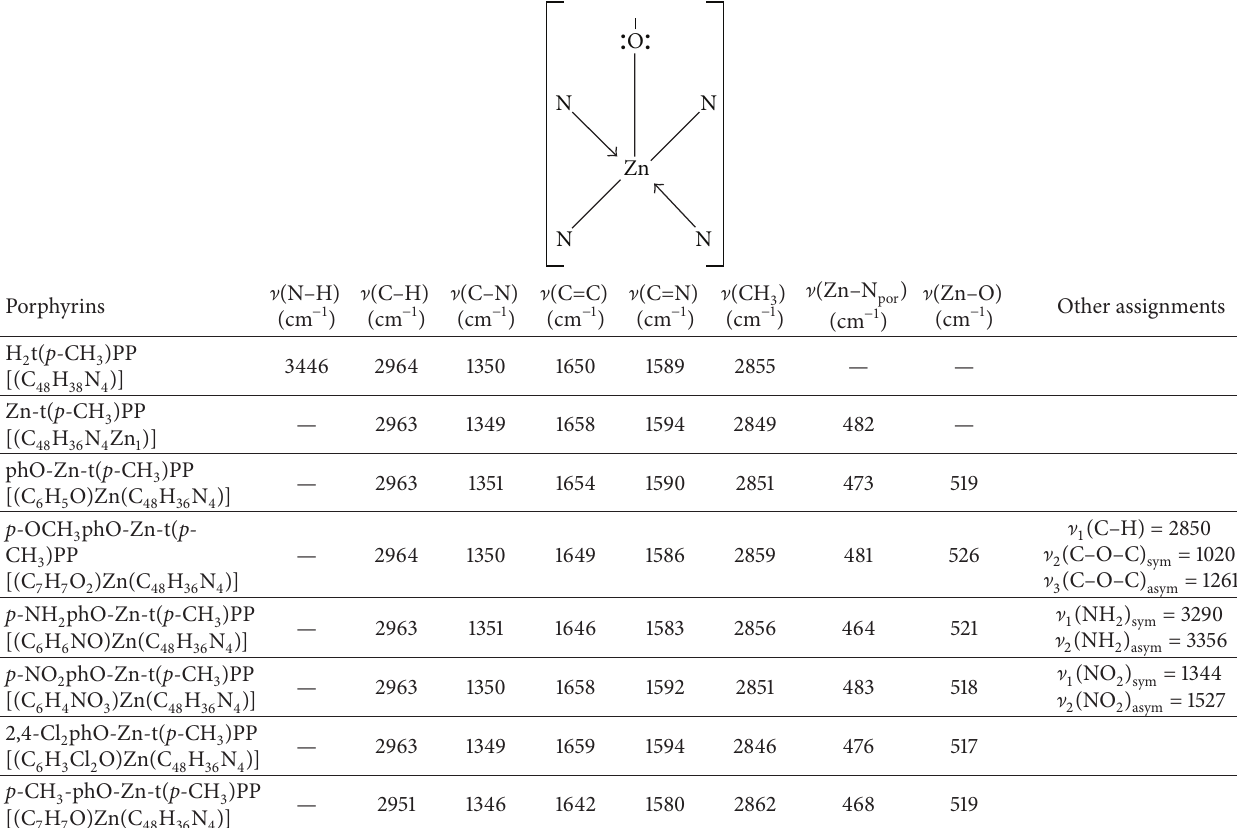
Table 4: Main vibrational frequencies corresponding to the various groups in X-Zn-t( p -CH